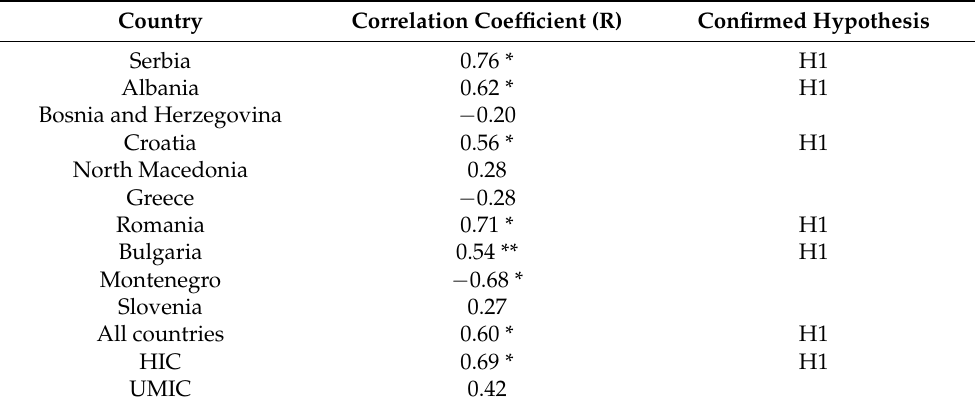
Table 5. Pearson correlation coefficient for FDI and CO 2 emission presented per country and for all countries, HIC and UMIC.